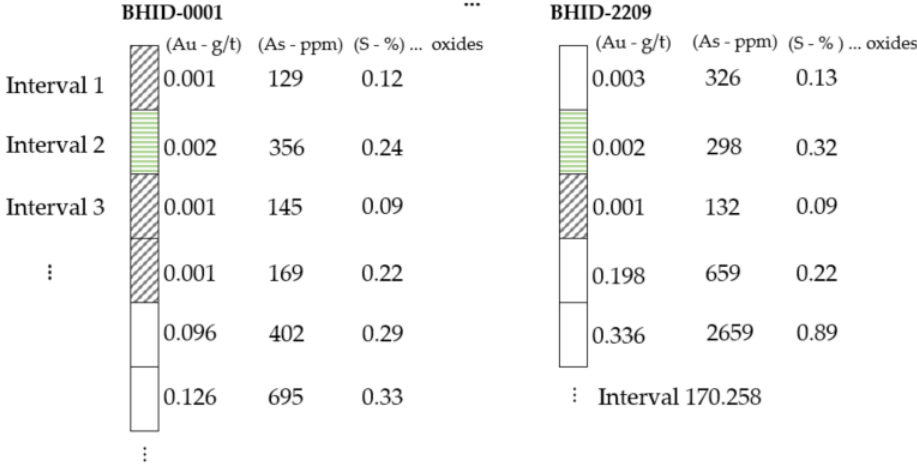
Figure 1. Drillholes scheme and analytical ranges. Gray and green hatching means similar gold grade ranges.